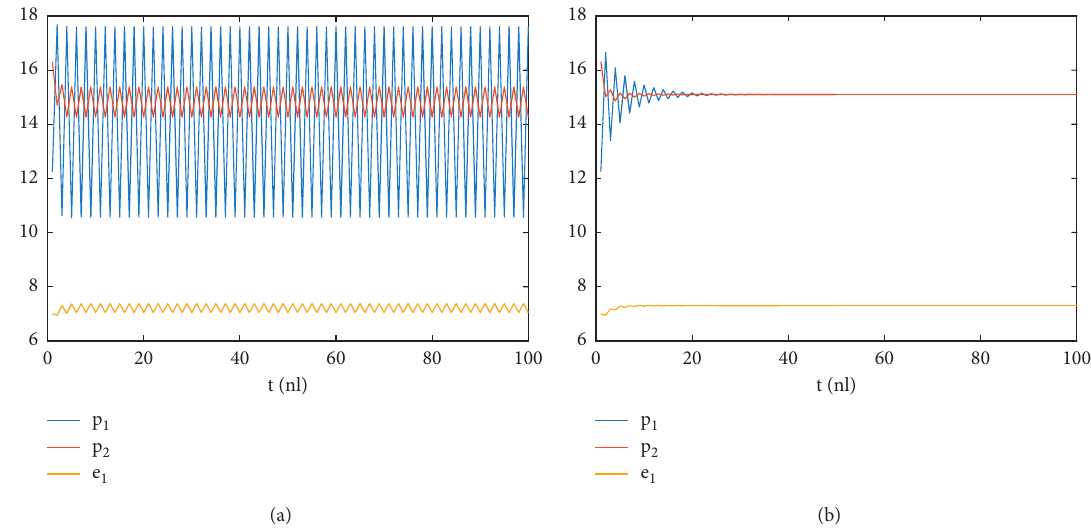
Figure 15: Price and carbon emission wave plot with the change of time when u